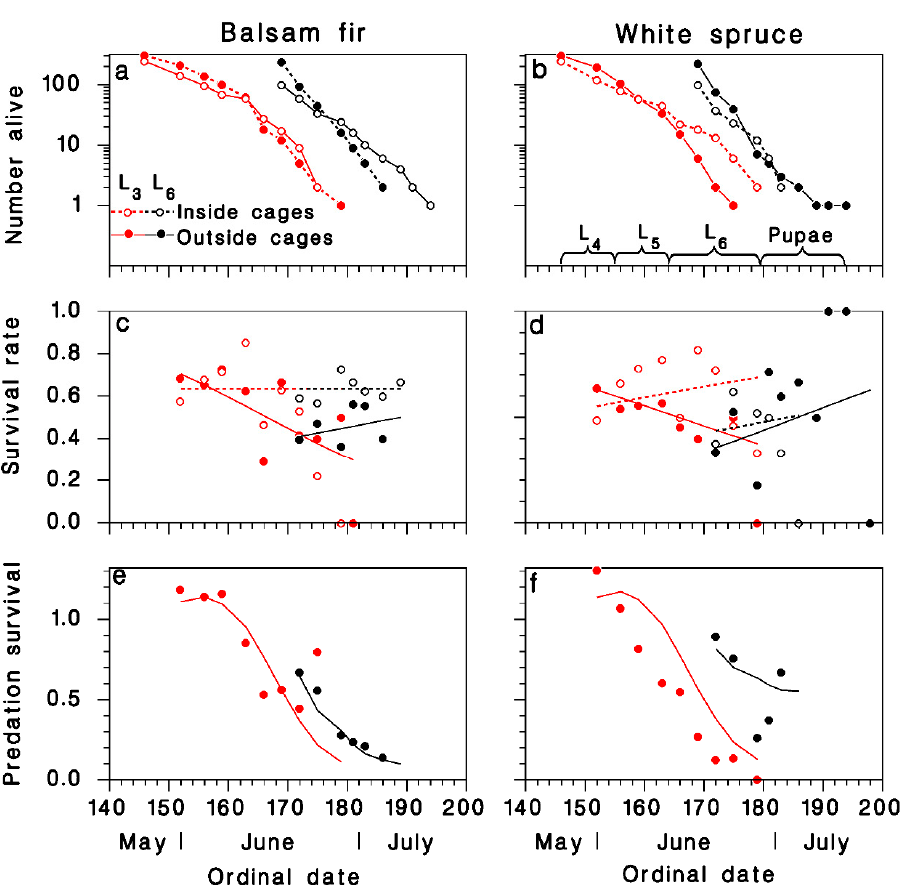
Figure 4. Survival among implanted cohorts in Armagh in 1987 on ( a , c , e ) balsam fir and ( b , d , f ) white spruce (red: L 3 cohort; black: L 6 cohort; Open circle: inside cages; closed symbols: outside cages). ( a , b ) number of live individuals. ( c , d ) Survival rate (lines: Equation (7); dotted: inside cages; solid: outside cages). ( e , f ) survival from predation calculated with